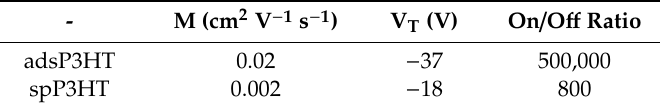
Table 1. Device performances in P3HT